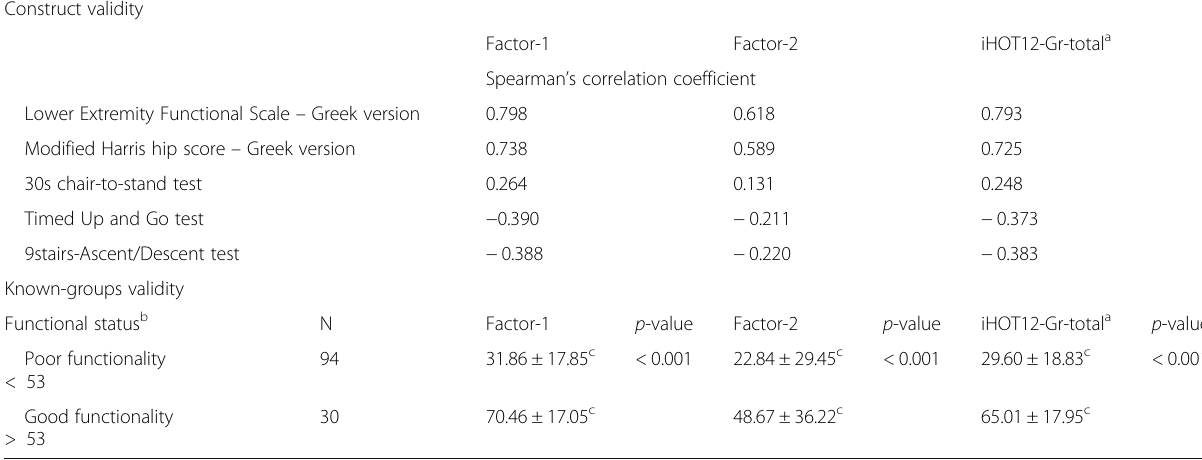
Table 5 Construct and known-groups validity of international hip outcome tool (12 items) - Greek version ( n = 124) Construct